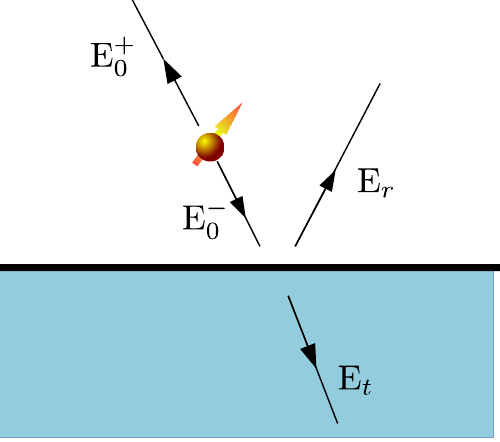
Figure 2. Representation of the primary field ( E ± ), emitted by a point dipole (represented by the golden 0 ball with an arrow), and the reflected ( E r ) and the transmitted ( E t ) field due to the presence of the interface at z = 0. The ± sign in E ± indicates whether the field is emitted along the positive/negative 0 z